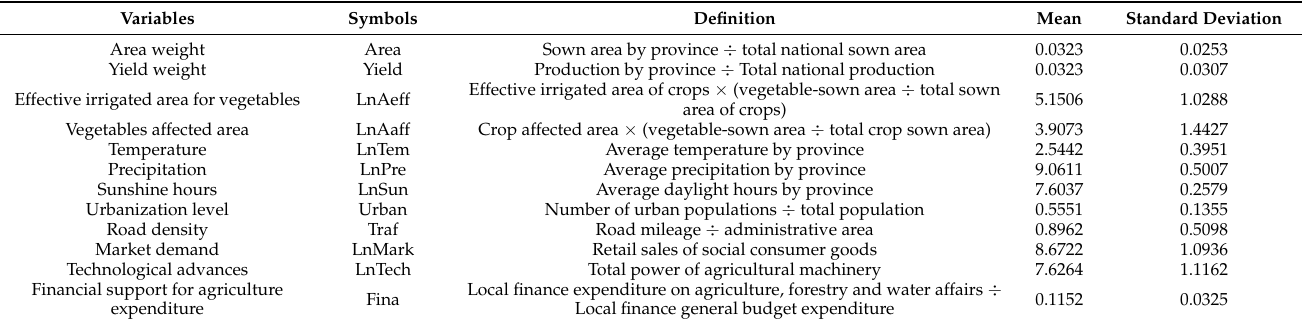
Table 1. Description and summary statistics of the studied